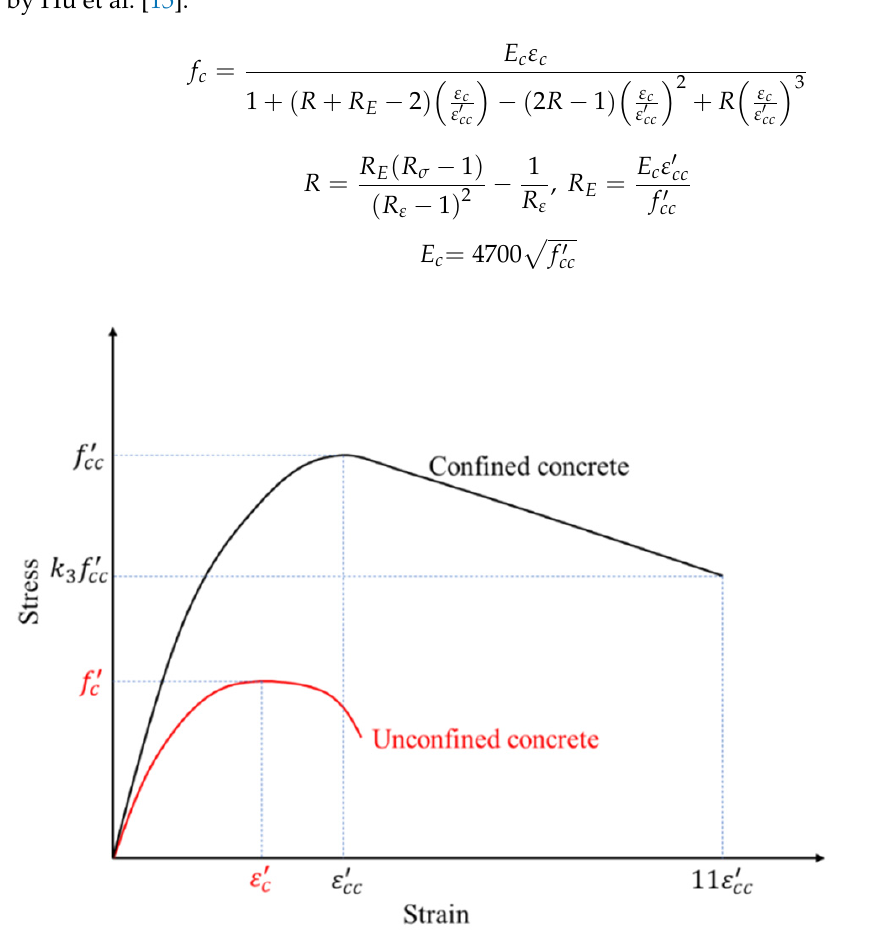
Figure 8. Uniaxial stress–strain curve for concrete.